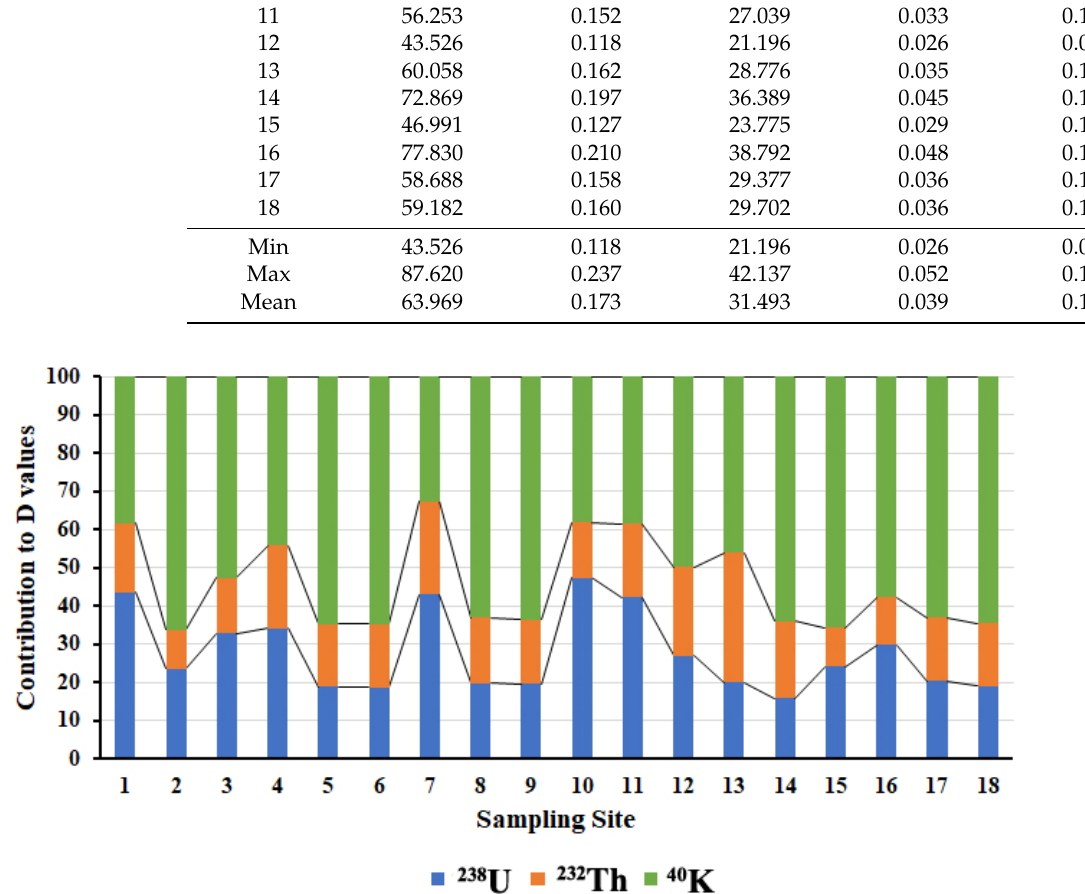
Figure 8. The contributions of 238 U, 232 Th, and 40 K to D values. The annual effective doses (AEDEs) for inhabitants were calculated based on D values. AEDE values ranged from 0.026 to 0.052 mSv yr − 1 (mean 0.039 mSv yr − 1 ). These values were lower than the worldwide average (0.07 mSv yr − 1 ) [1] in all the studied sediment samples. Long-term exposure to ionizing radiation typically leads to further risks described as excess lifetime cancer risk (ELCR). To obtain a better insight of the health effects of external exposure to the measured natural radionuclides in Jeddah coast marine sediments, ELCR factors were calculated using AEDE values. The obtained values ranged from 0.091 × 10 − 3 to 0.181 × 10 − 3 (mean 0.135 × 10 − 3 ). The ELCR-calculated values are lower